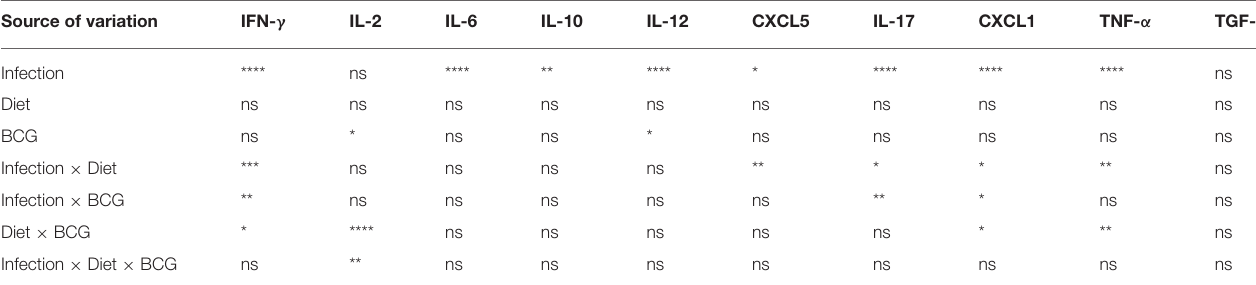
TABLE 3 | P -value summary of three-way ANOVA from cytokines quantified in lungs (* p < 0.05; ** p < 0.01; *** p < 0.001; **** p < 0.0001). Source of